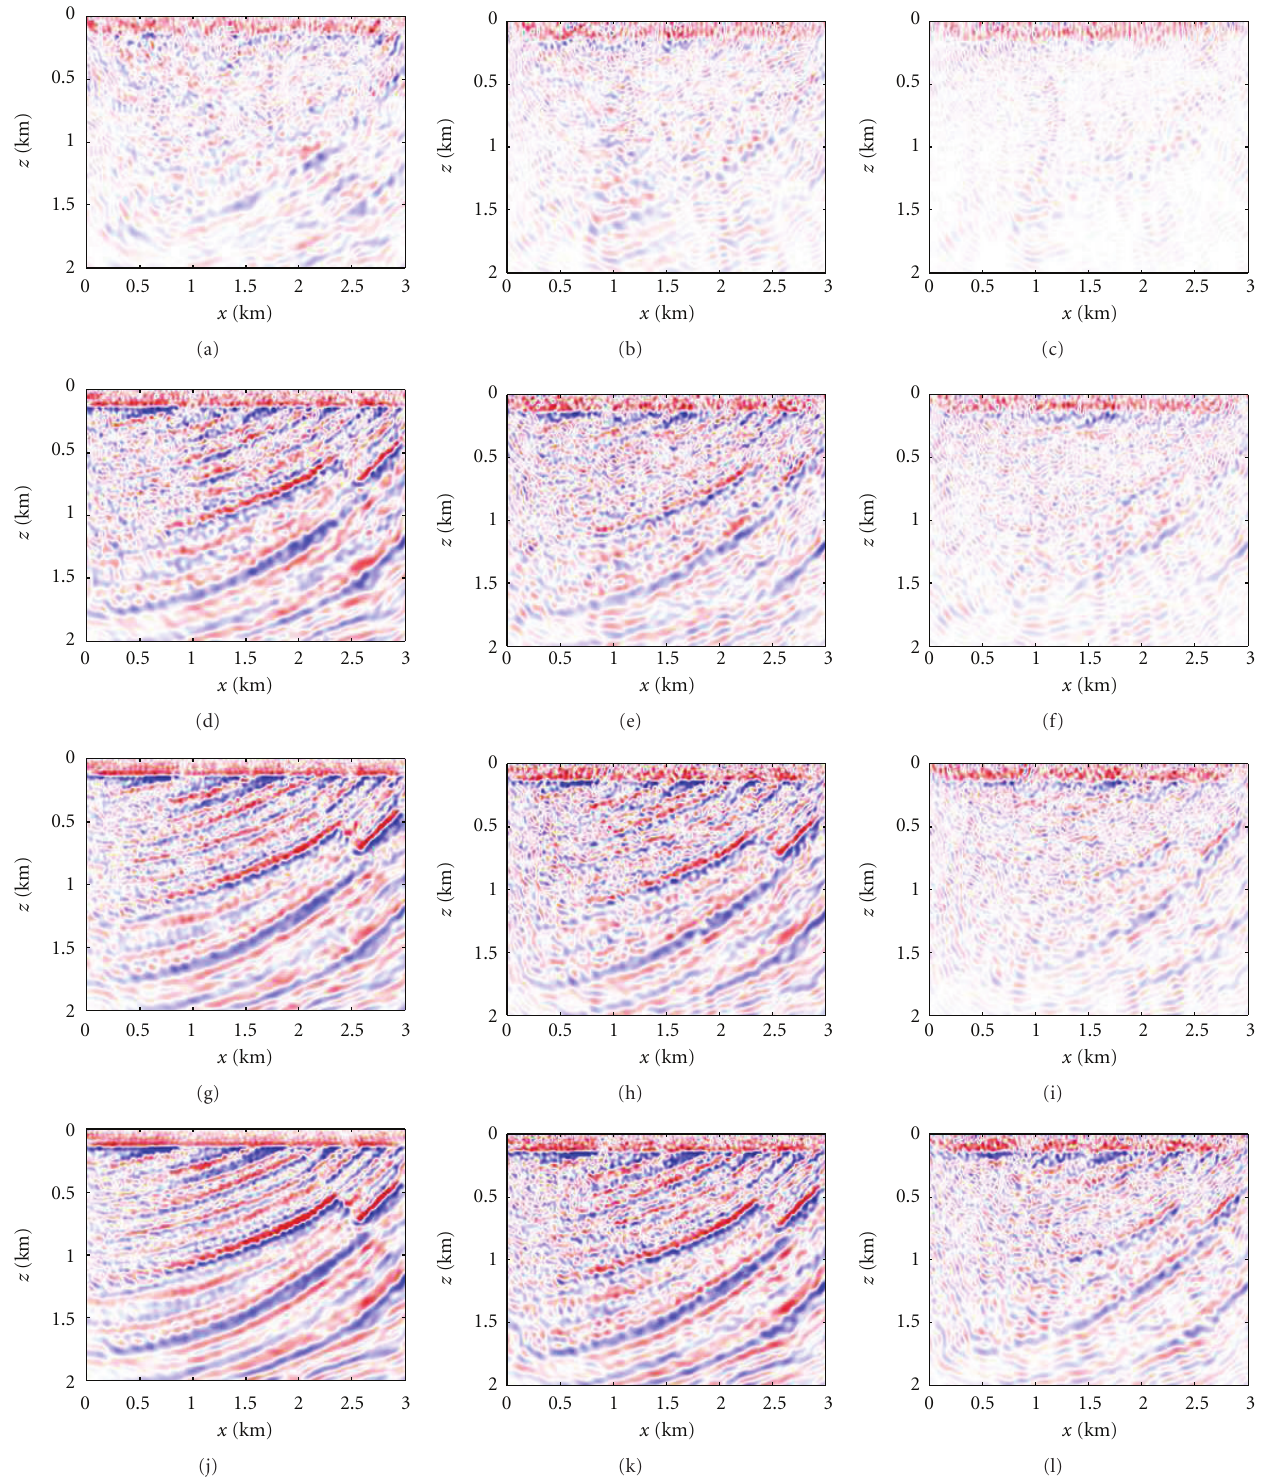
Figure 7: Inversion result for the SAA approach with various batch sizes and noise levels. The rows represent di ff erent batch sizes K = 1, 5, 10, 20, while the columns represent di ff erent noise levels: no noise, SNR = 20dB, and SNR = 10dB. The reconstruction with K = 20 for noiseless data (j) is qualitatively comparable to the full reconstruction. The quality deteriorates quickly for small batch sizes and noisy